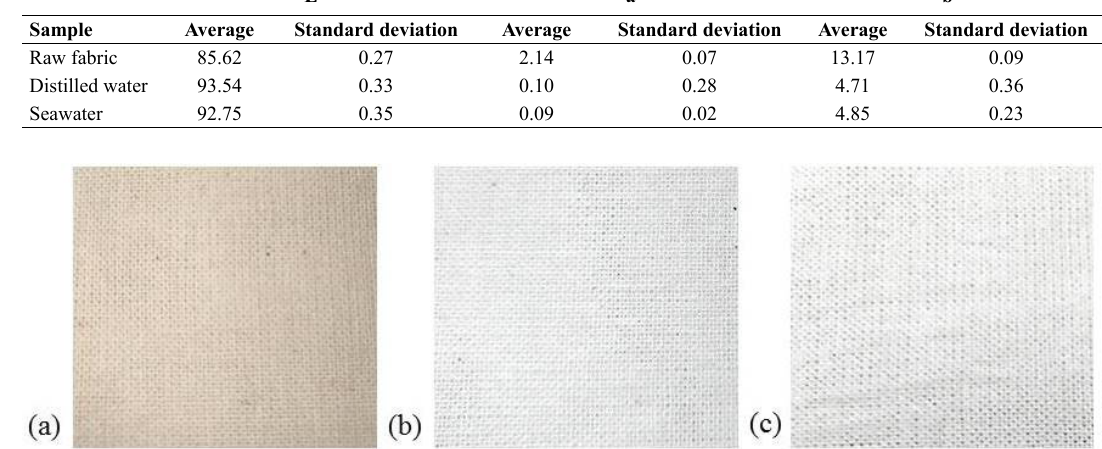
Figure 2. Sample images: (a) Raw fabric, (b) Fabric bleached with distilled water and (c) Fabric bleached with